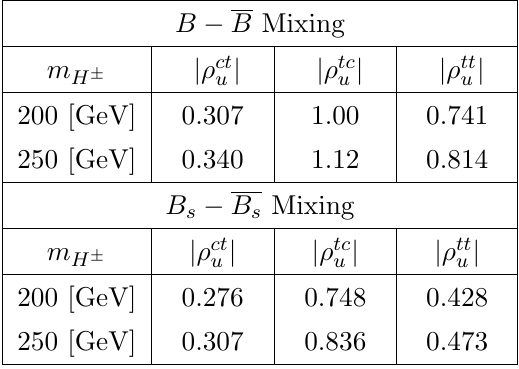
Table 1 . The upper bounds on the up-type Yukawa couplings from the (cid:1) F = 2 processes, (cid:12)xing m at m = 200 GeV and 250 H (cid:6) H (cid:6)